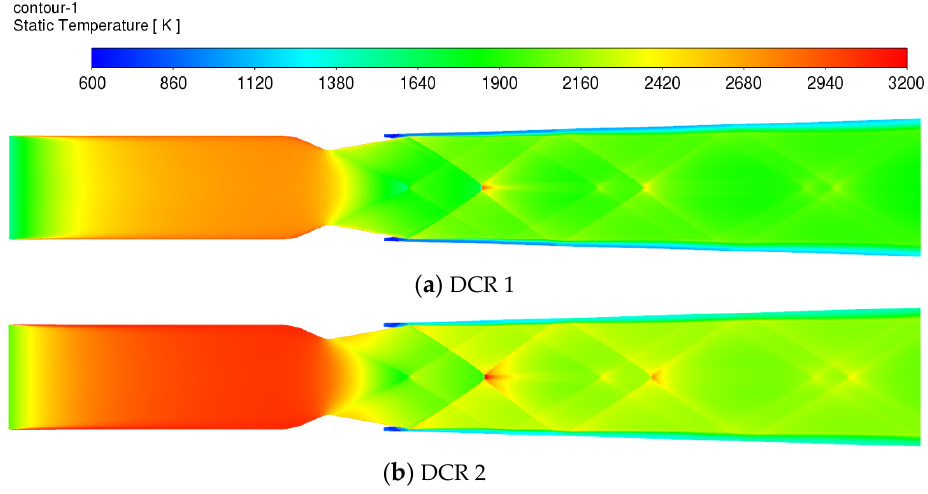
Figure 10. Static temperature contours for DCR 1 and DCR 2.